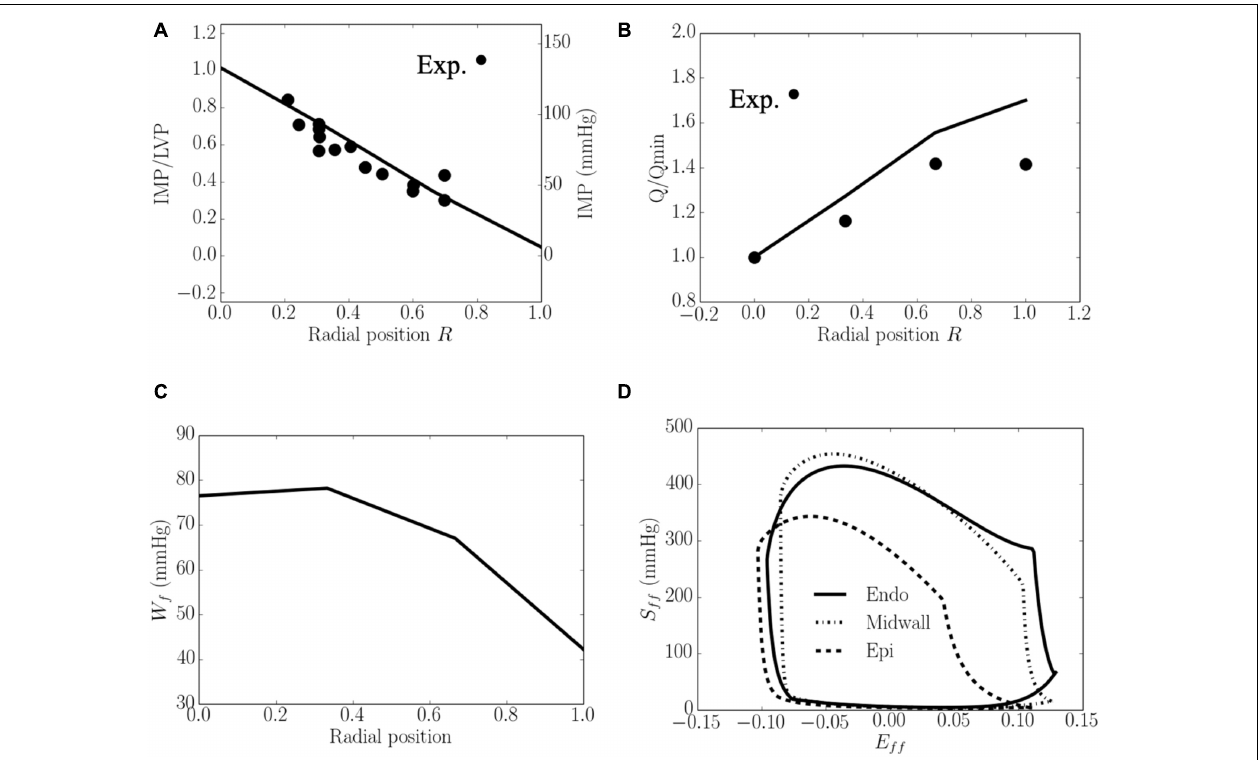
FIGURE 4 | Transmural distribution. (A) IMP that normalized against LV pressure, is comparable to experimental measurements (Heineman and Grayson, 1985); (B) Total coronary flow over a cardiac cycle that is normalized by flow at the endocardium ( R = 0), is comparable to the measurements in a canine model under maximal coronary vasodilation (Vatner and Hittinger, 1993); (C) Work done over a cardiac cycle W f . (D) Average S ff − E ff loop at the endocardial ( R = 0), mid-wall and epicardial ( R = 1) regions. · denotes experimental